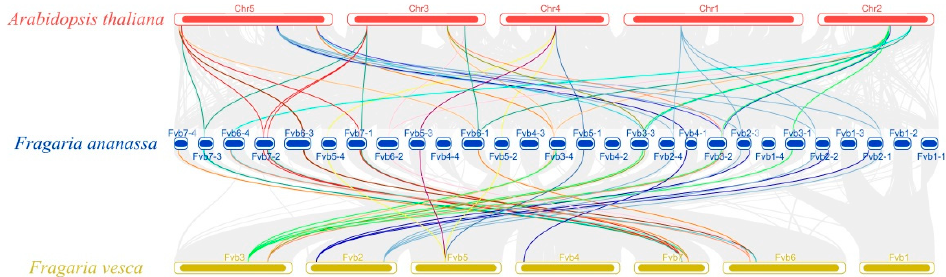
Figure 6. Synteny analysis of C2H2-ZFP C1-2i subclass in A. thaliana , F. × ananassa, and F. vesca genomes. The colored rounded rectangles represent the chromosomes of the three plants. The gray curves are the collinear gene regions within the genomes of the three species, and the colored curves represent the gene pairs that are collinear with the C2H2-ZFP C1-2i subclass.